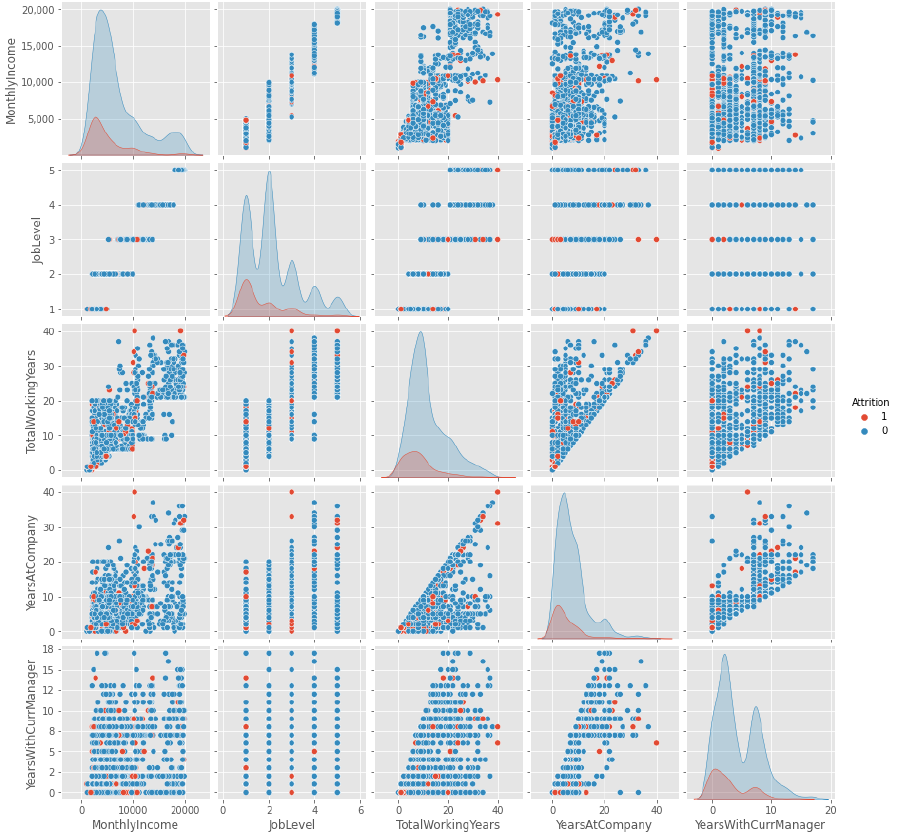
Figure 5. The pair plot data distributions analysis of features monthly income, job level, total working hours, years at the company, and years with the current manager role.